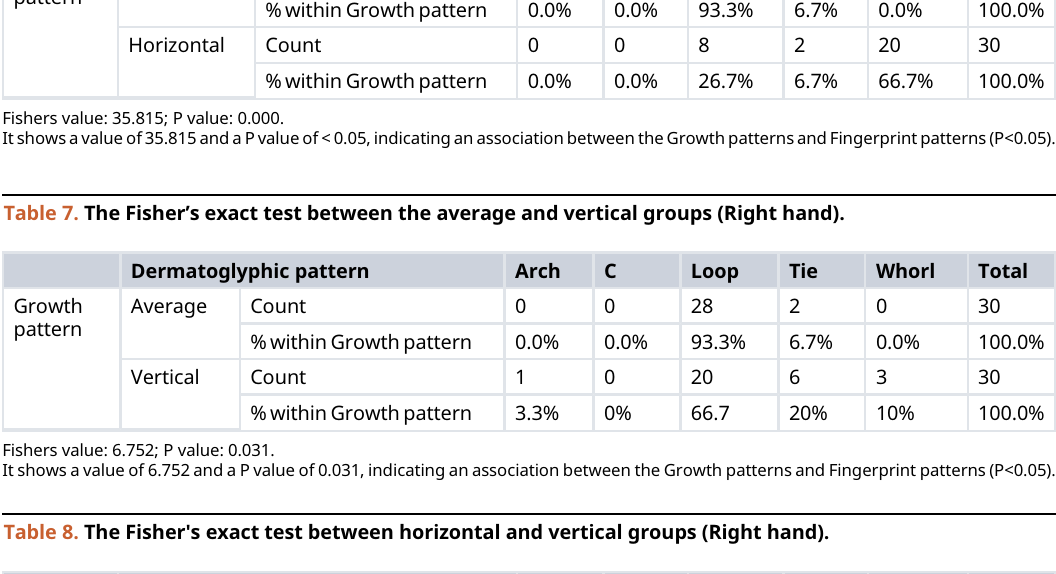
Table 6. The Fisher ’ s exact test between the average and horizontal groups (Right hand). Dermatoglyphic pattern Arch C Loop Tie Whorl Total Growth Average Count 0 0 28 2 0 30 pattern %withinGrowthpattern 0.0% 0.0% 93.3% 6.7% 0.0% 100.0% Horizontal Count 0 0 8 2 20 30 %withinGrowthpattern 0.0% 0.0% 26.7% 6.7% 66.7% 100.0%